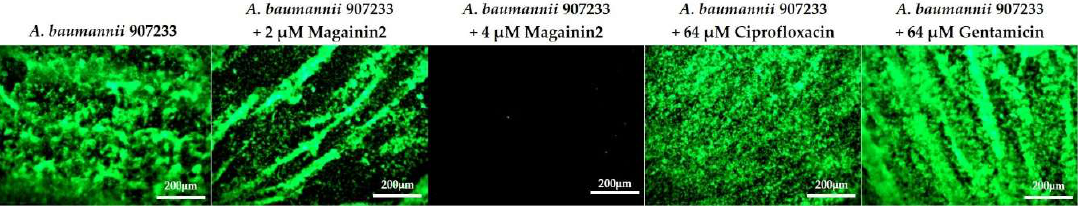
Figure 5. EVOS2 images of Acinetobacter baumannii biofilm stained with SYTO9 dye (green fluorescence).